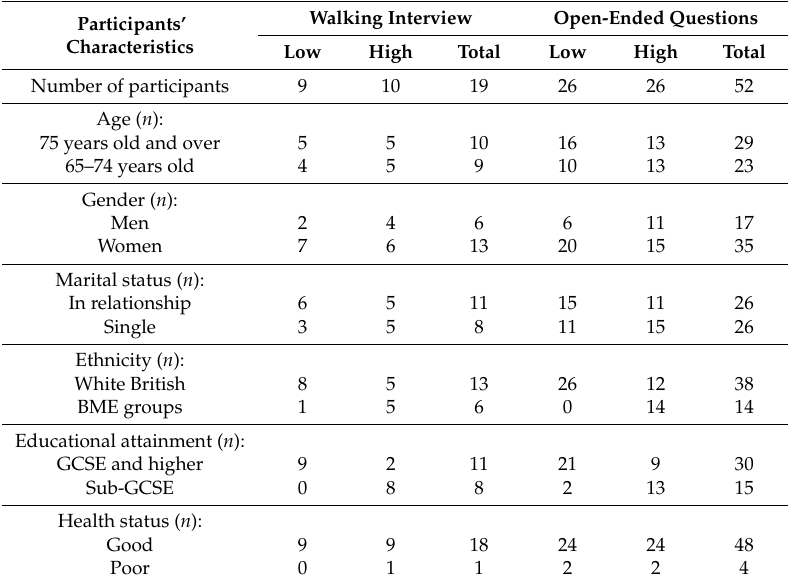
Table 3. Detail information about participants who provided qualitative